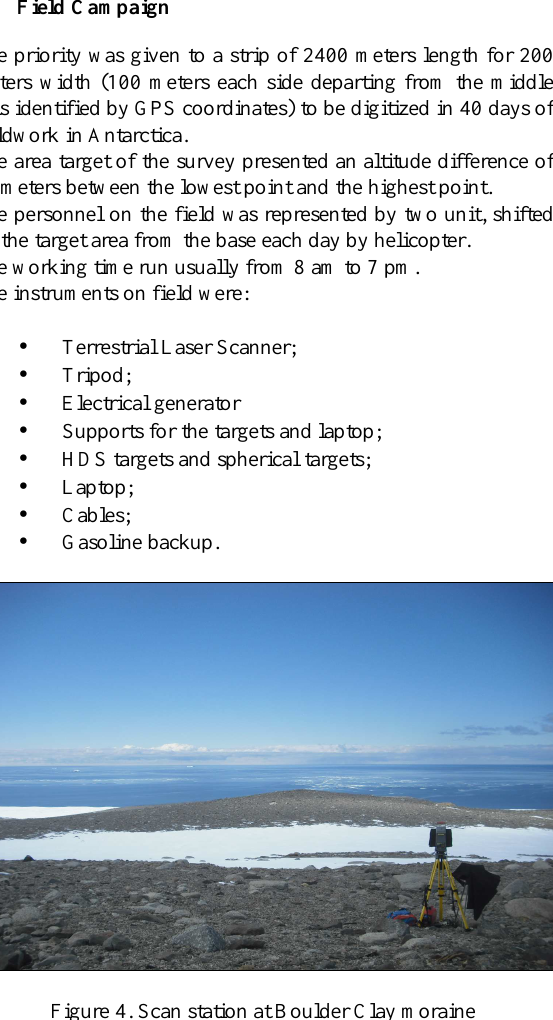
Figure 4. Scan station at Boulder Clay moraine